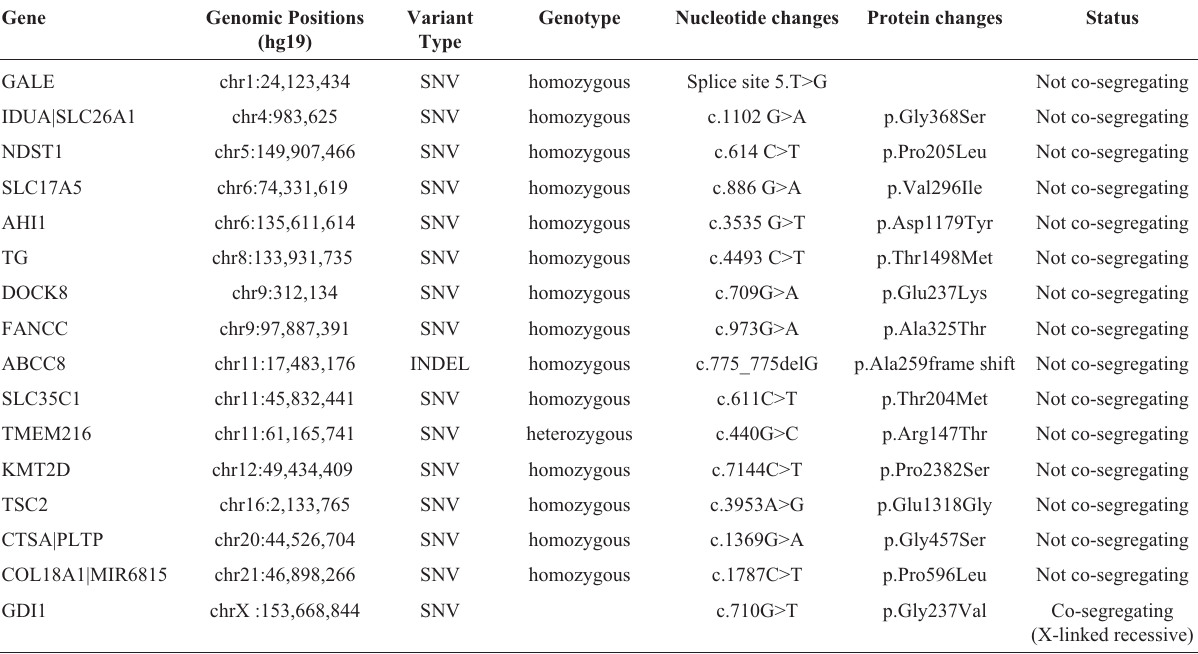
Table 1 - Candidate mutations of the SZMRX family identified by whole exome sequencing # . Gene